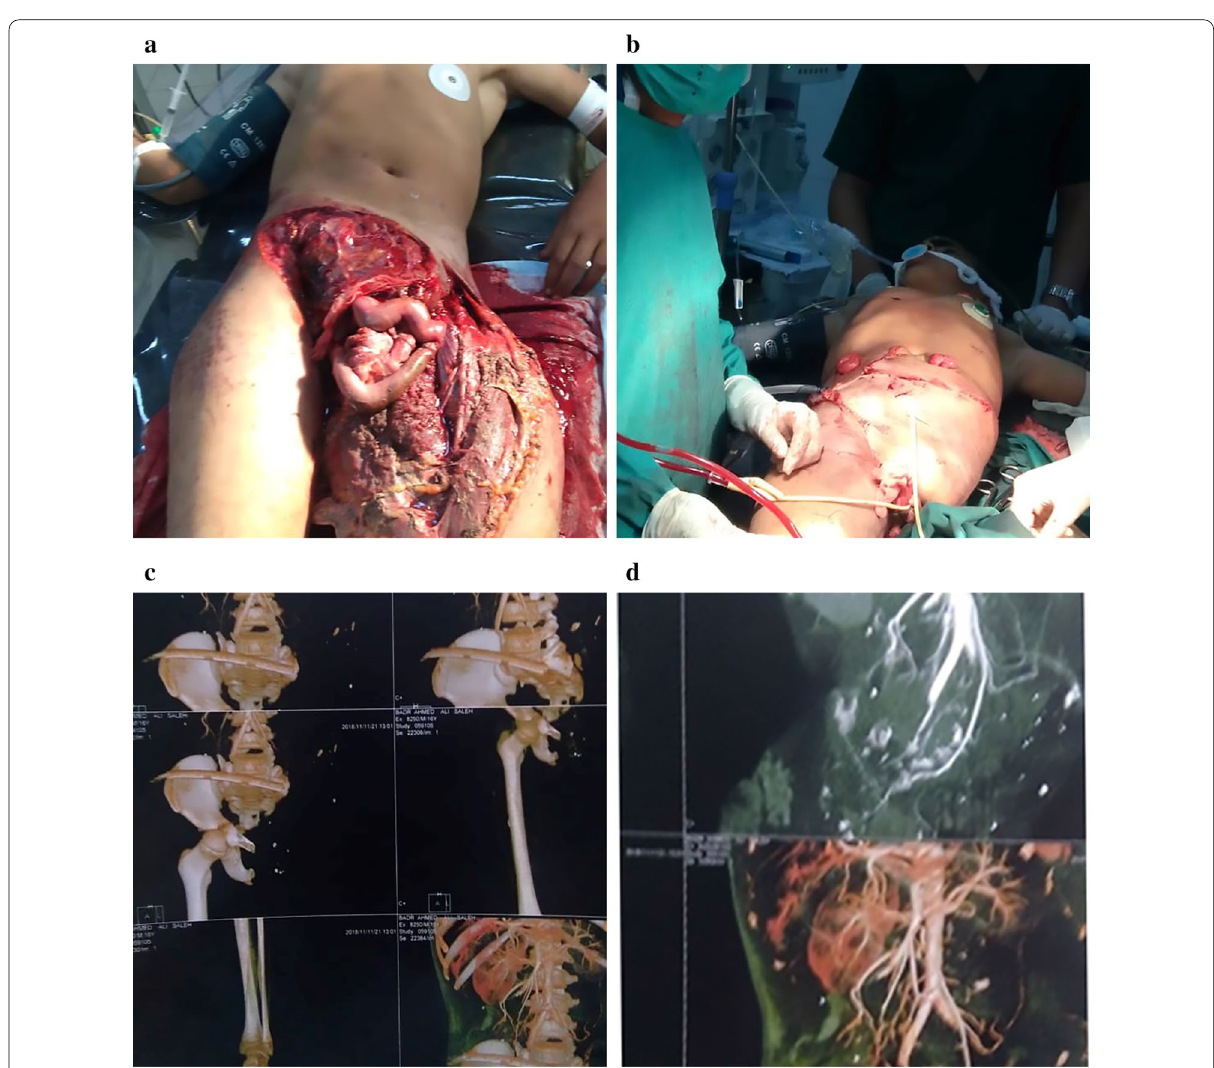
Fig. 1 a Details of the wound on the left pelvic side before the initial operation [lower abdomen with exposed urinary bladder, eviscerated bowel, destructed perineum, and almost complete avulsion of the left lower extremity]. b Postoperative clinical situation with left traumatic hemipelvectomy and an ipsilateral anterolateral thigh flap, achieving the primary closure of the wound. c Radiological study showing dislocation of the right sacroiliac joint and symphysis pubis with only some ligamentous attachment. d Computed tomography angiography of the pelvis and right lower extremity indicating the absence of blood flow to the right lower